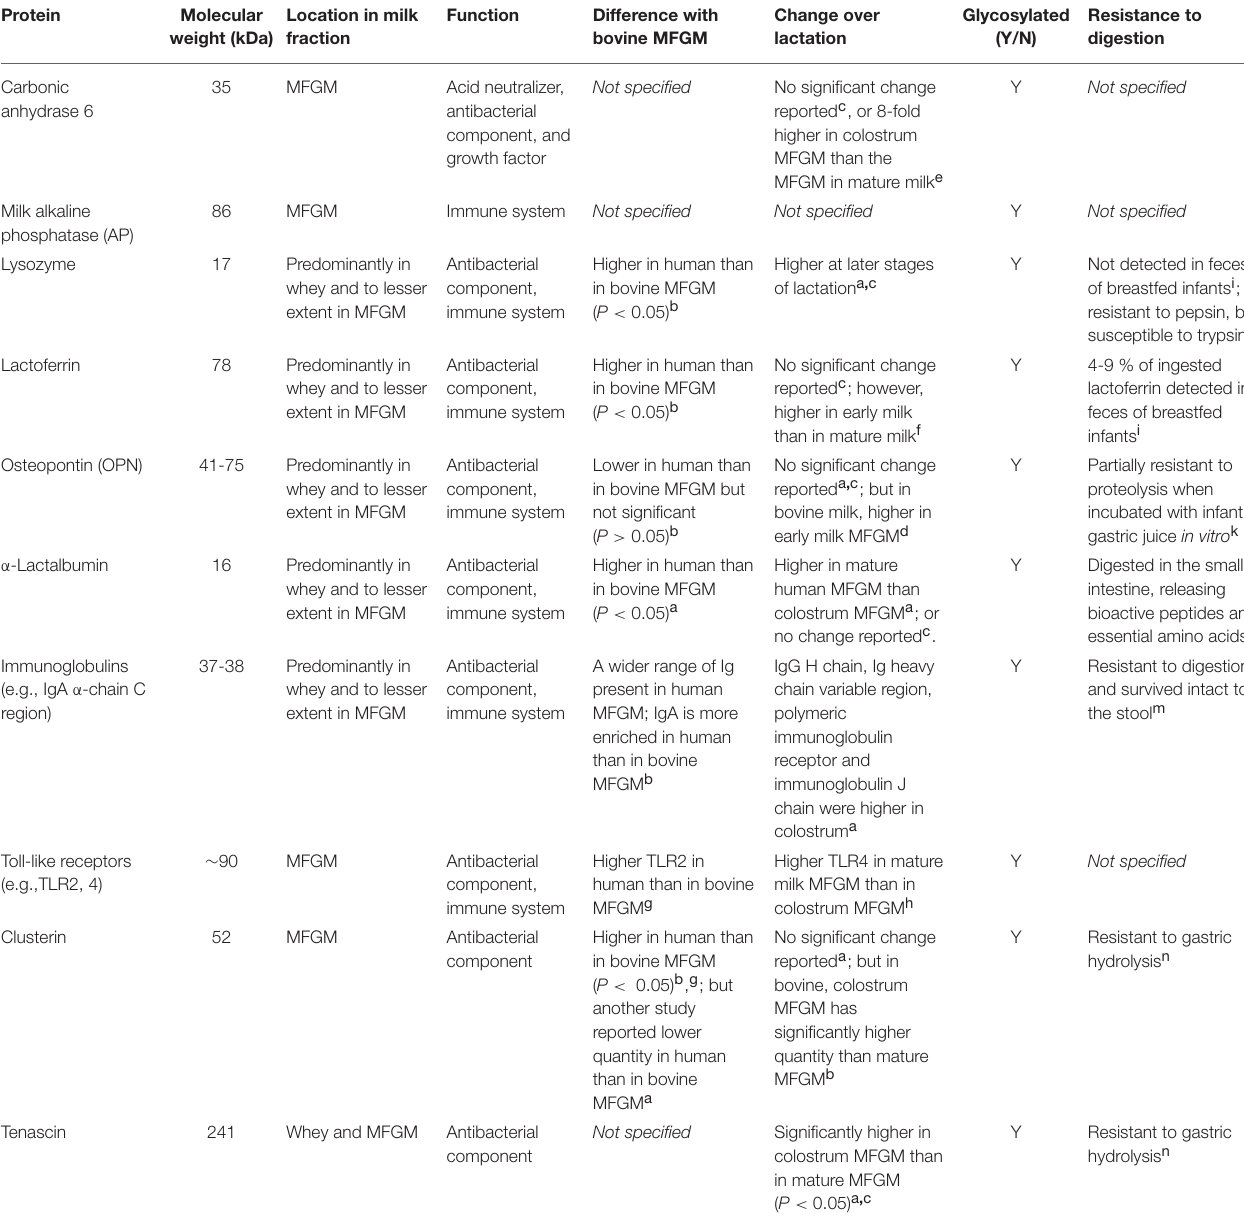
TABLE 3 | Properties of minor human milk fat globule membrane (MFGM) proteins.